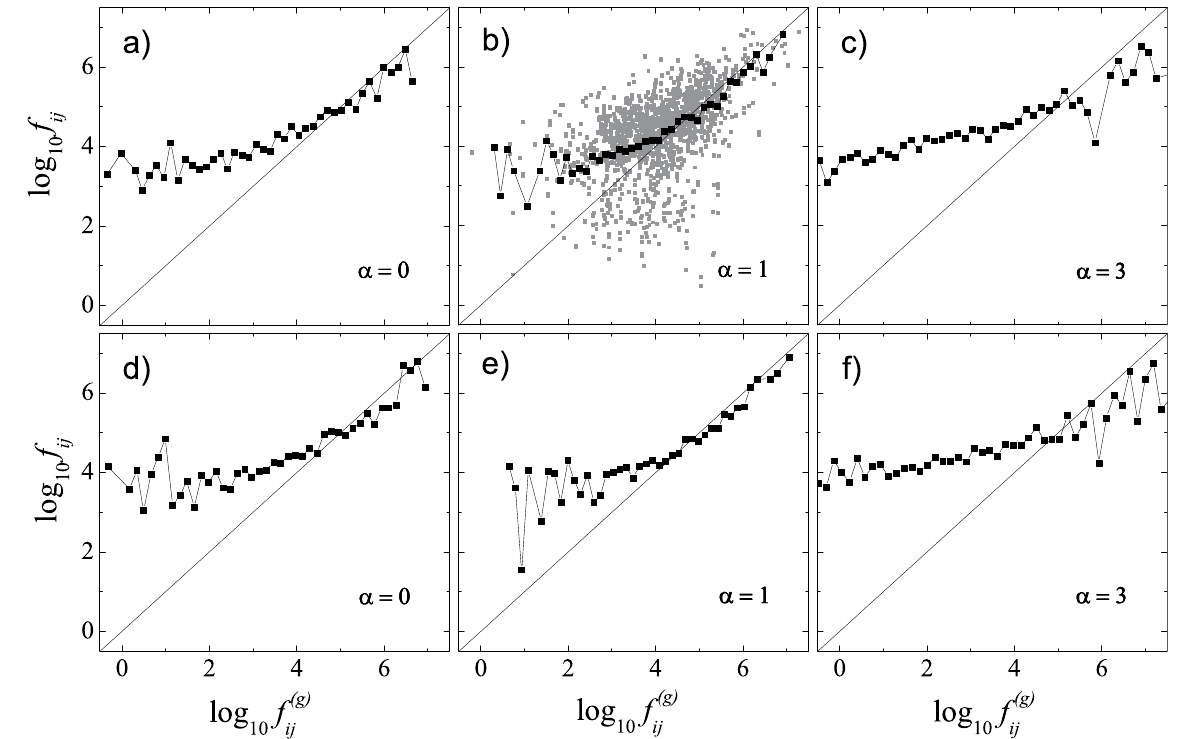
Figure 1. The observed weights of connections in the airline network, f ij , vs. their expected values, f ijg ( ) . Plots in the same row correspond to the same year: 1996 (top row) and 2004 (bottom row). Values of the distance coefficient α are indicated in the plots. All data are logarithmically binned (black squares). In panel (b), we have also shown raw data for comparison (grey